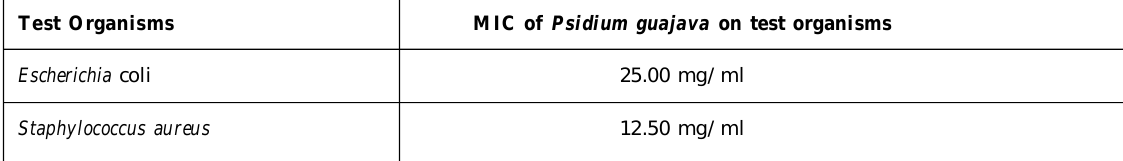
Table 2: Minimum Inhibitory Concentration (MIC) of Psidium guajava leaf extract on test organisms Test Organisms